Question: In one sentence, what is this figure communicating?
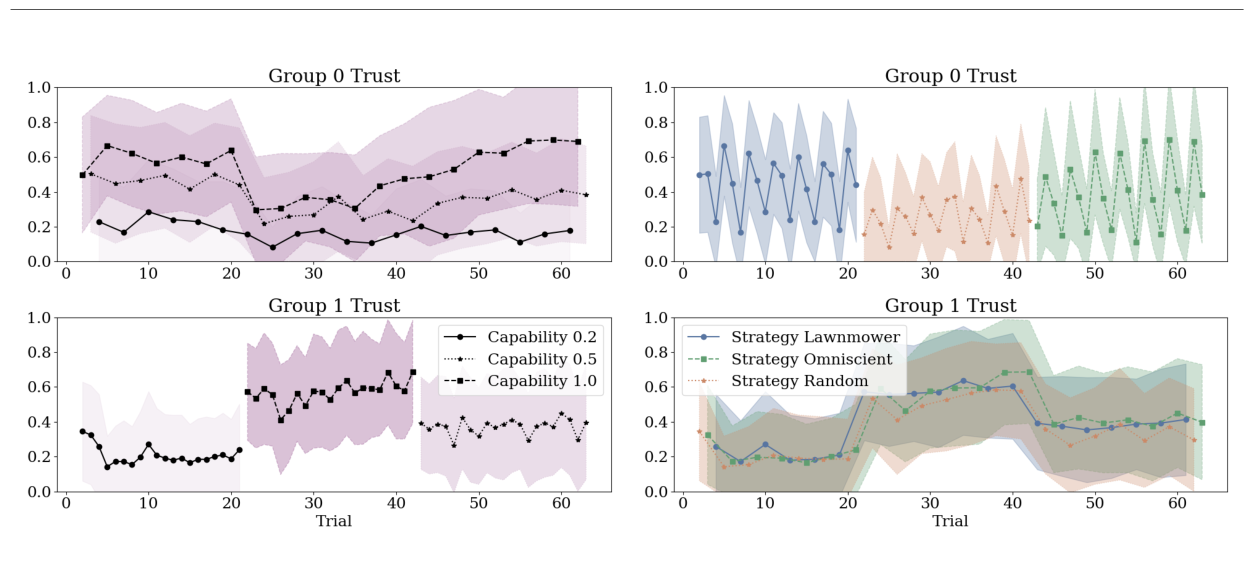
Answer: Each group’s average trust ratings throughout the experiment. The data across rows are the same but colored and connected to emphasize the contributions of each experimental block to the rating. Since capability likely contributes more to an individual’s trust rating and Group 1 saw a constant searcher capability, their ratings were more stable. The oscillations for Group 0 can be attributed to the varying performance of the searchers over a short frequency. The colors in this figure correspond to those in Figure 3.